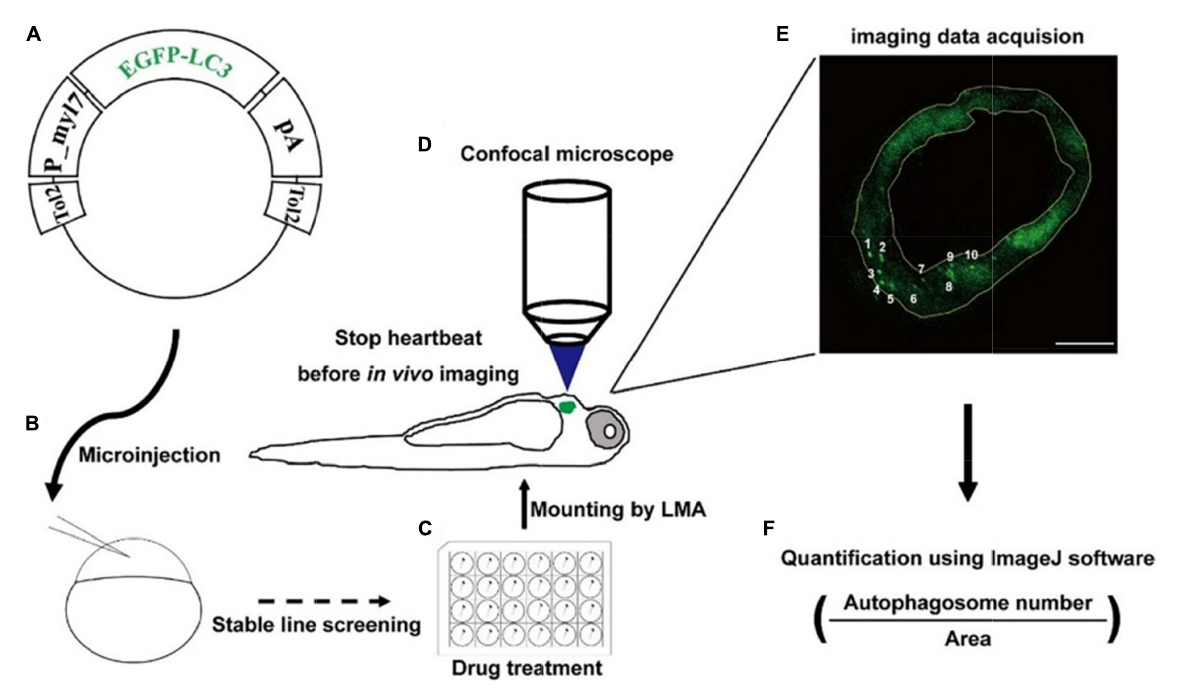
FIGURE1 Strategy of monitoring autophagic activity in zebrafish cardiomyocytes in situ . (A) The structure of transgenic plasmid for labeling autophagosomes. (B) Microinjection of the transgenic mixture into one-cell staged embryos for generating stable lines. (C) Drug treatment of zebrafish larvae using cell culture plates. (D) Transgenic larvae are mounted, stopped heartbeat, and then imaged under a confocal microscope. (E) Confocal image shows the EGFP-positive puncta that are characterized as autophagosomes. The area of heart tissue is selected by a yellow polygon using the ImageJ software. Arabic numerals show autophagosomes. Scale bar: 20 µ m. (F) The density is calculated by dividing the number of autophagosomes by the area of heart